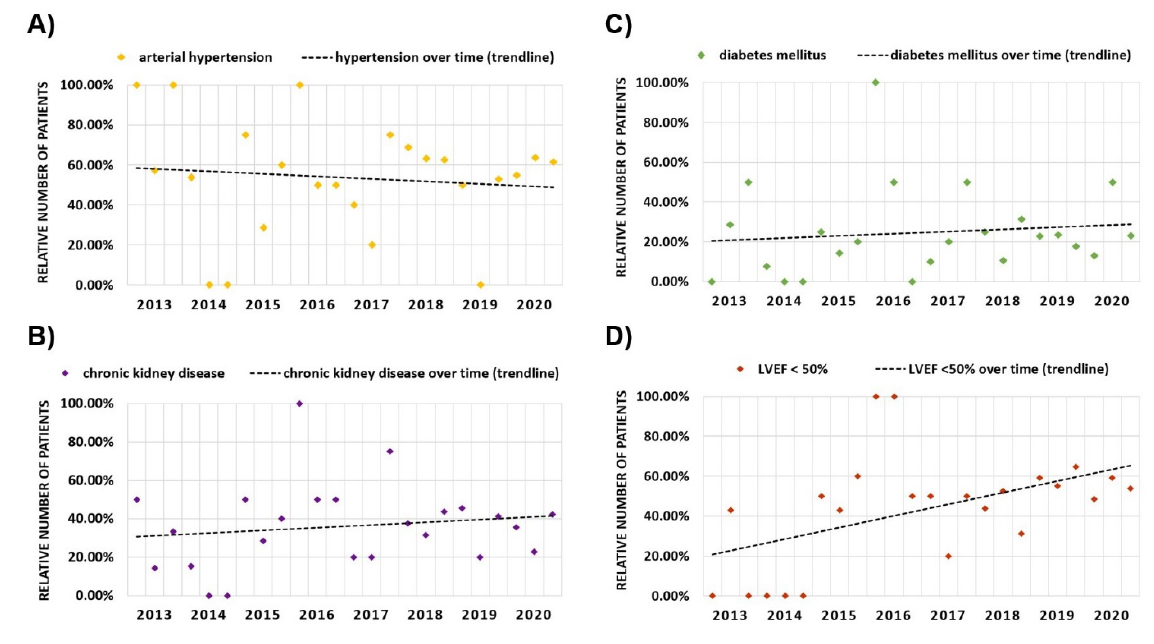
Figure 4. Mean patient age at TLE. Mean patient age at extraction including standard error of the mean for every four-month period and trendline analysis. Only a single patient was recorded for 2014 T3; therefore it is without standard error of the mean.